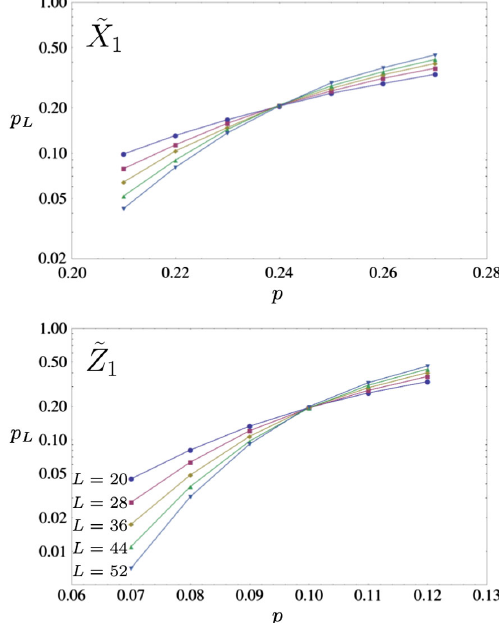
~ X ~ Z of the logical operators 1 and 1 L ≈ 24% for ~ X ≈ 10% 1 and p c c